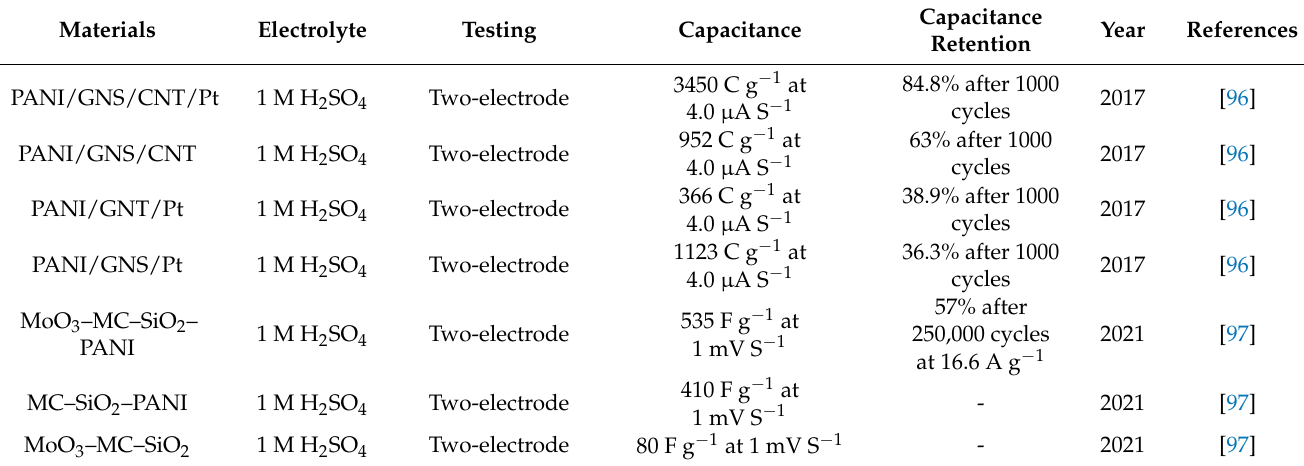
Table 3. Electrochemical performance of the two quaternary